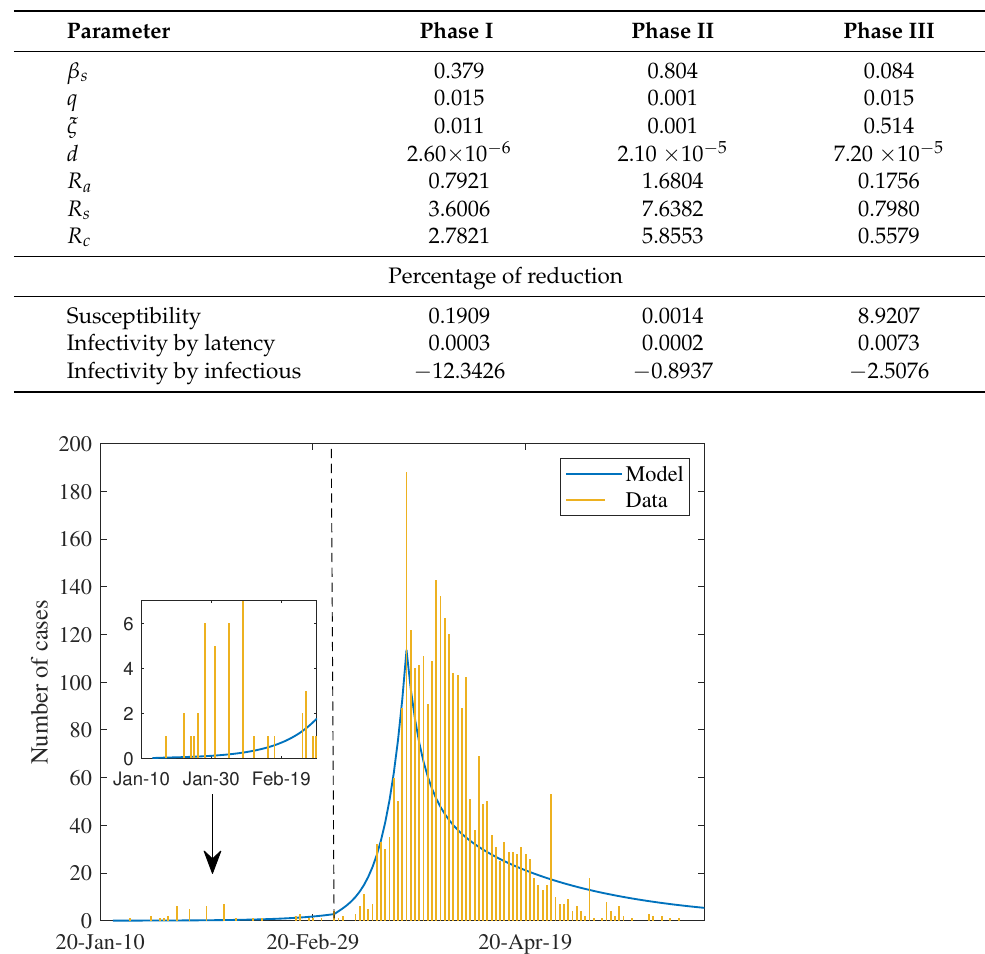
Table 2. Estimation of parameters, the reproduction numbers, and percentage of reduction for the first wave.